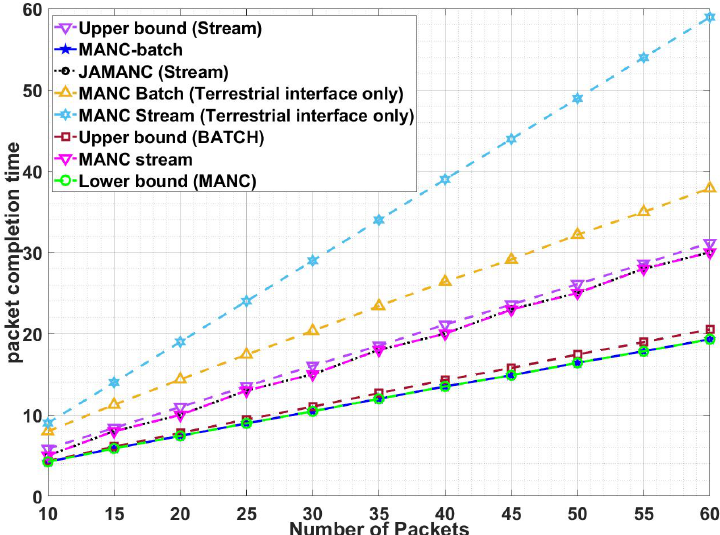
Figure 9. No. of packets vs. completion time (lossless second